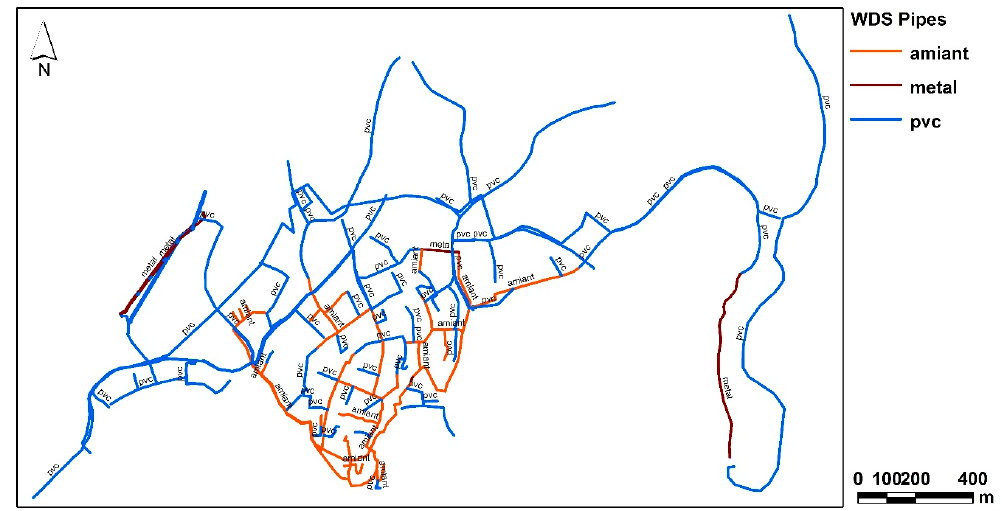
Figure 4. Water distribution network (WDN) map of pipe materials.